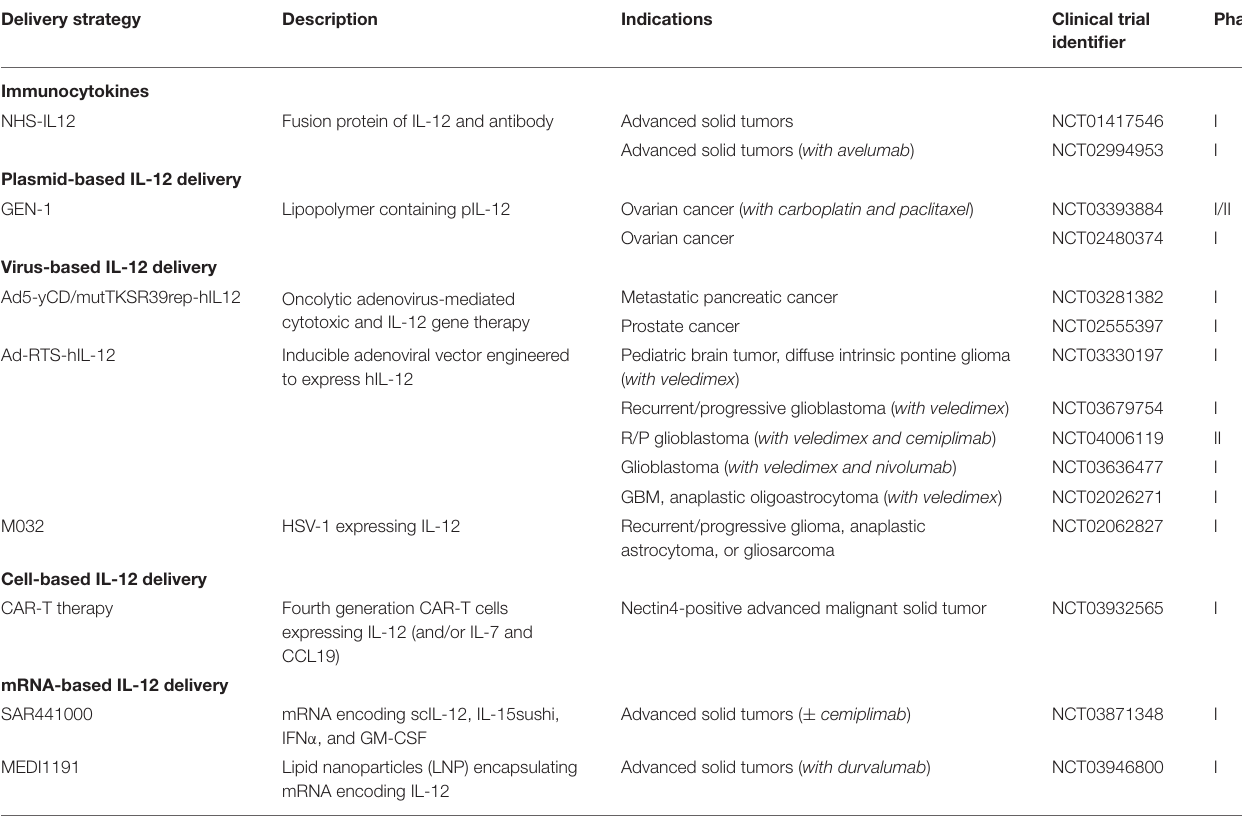
TABLE 2 | Summary of current clinical trials using localized IL-12 delivery strategies